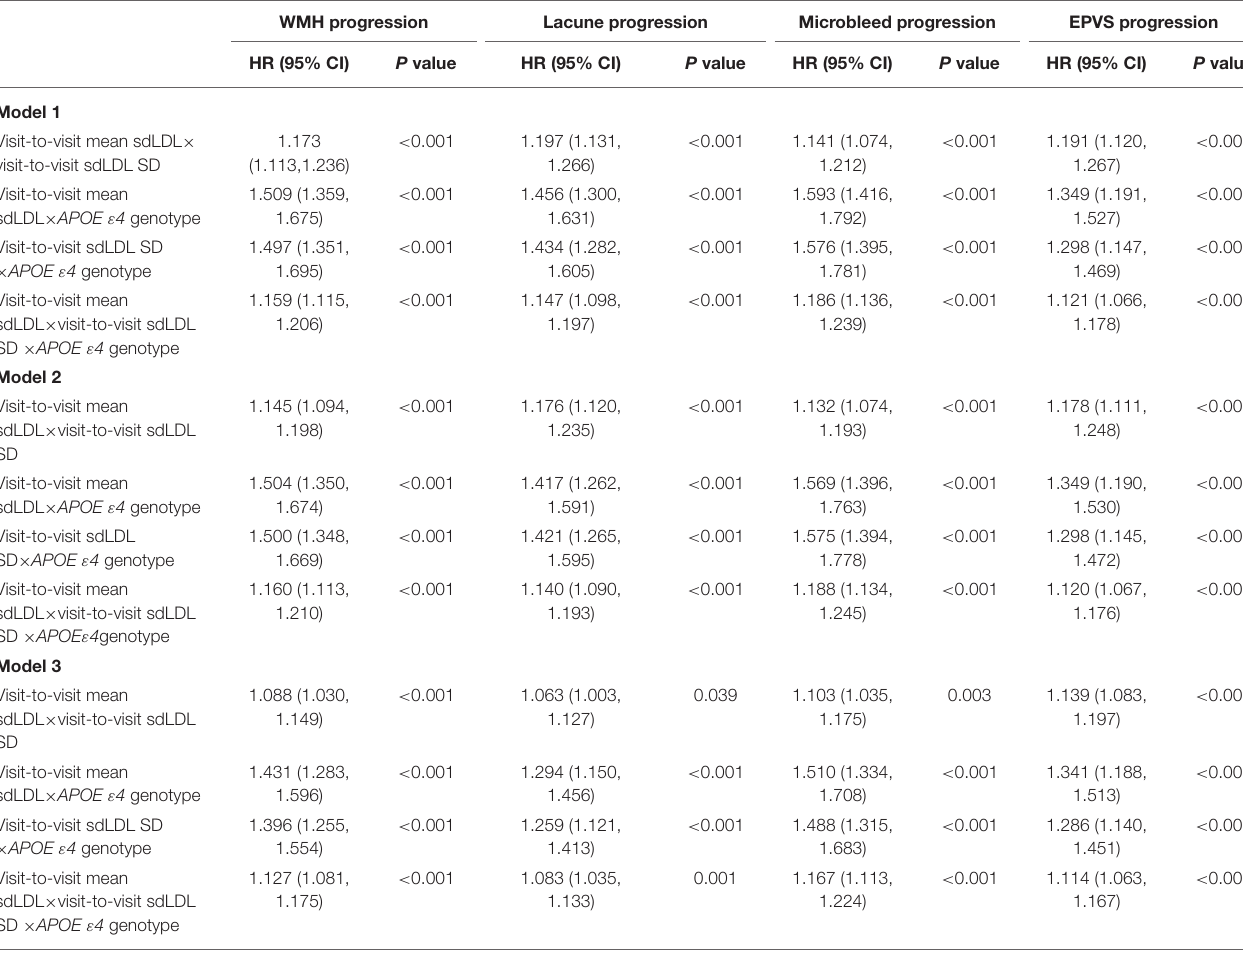
TABLE 2 | Interactions among visit-to-visit mean sdLDL, visit-to-visit sdLDL variability, and APOE genotype influencing cerebral small vessel disease progression. WMH progression Lacune